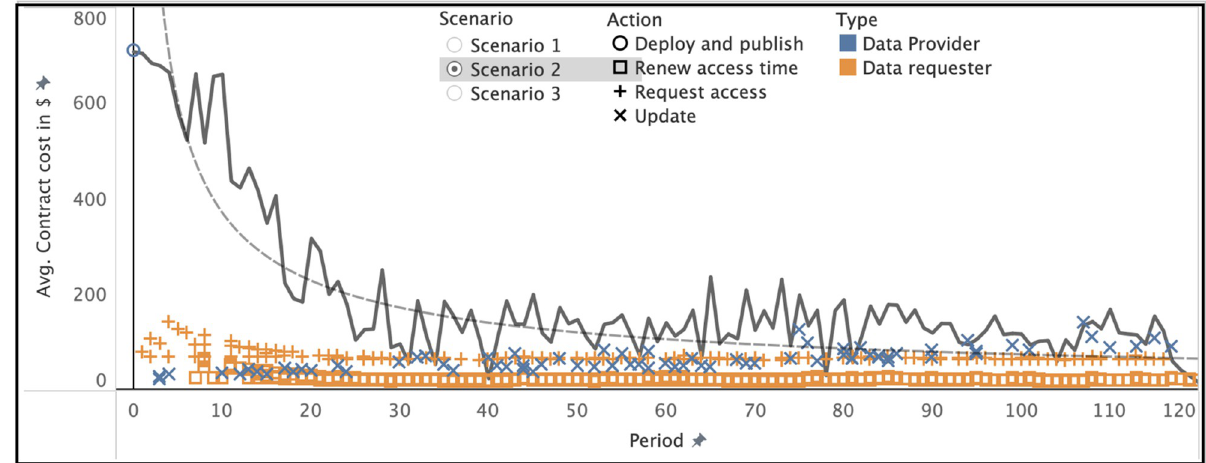
Fig 4. Running costs of a smart contract over a period of time in scenario